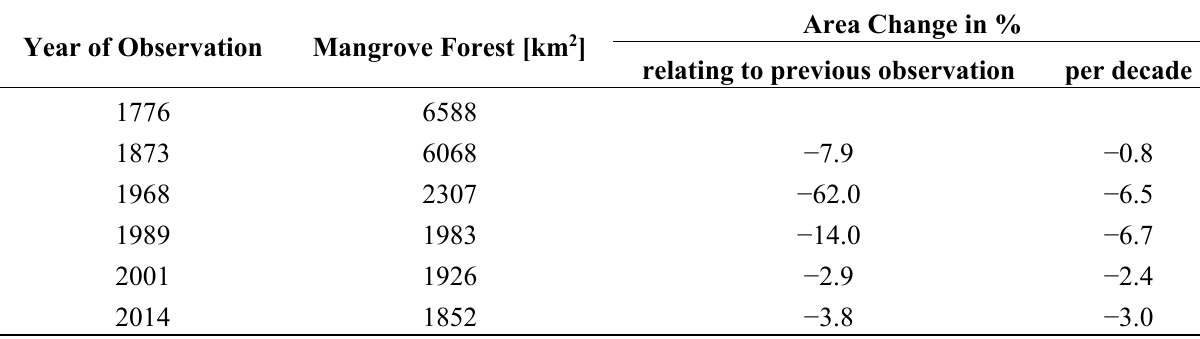
Table 2. Change statistics of mangrove extent and cover for the last two-and-a-half centuries. Year of